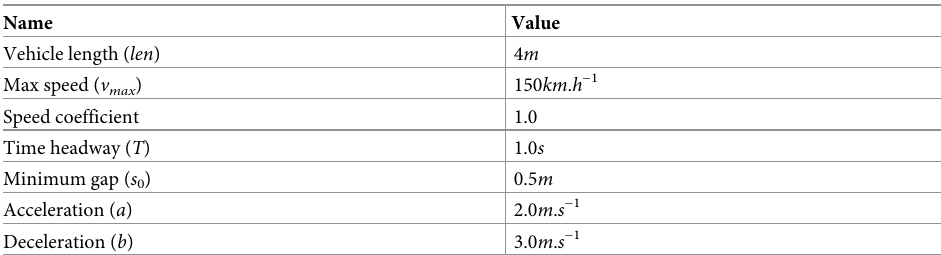
Table 8. Driver parameter values for the